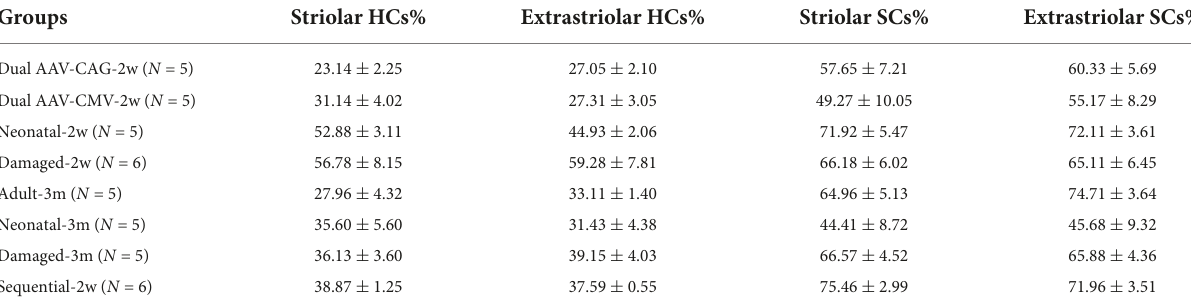
TABLE 1 Summary of the co-transduction rate of each